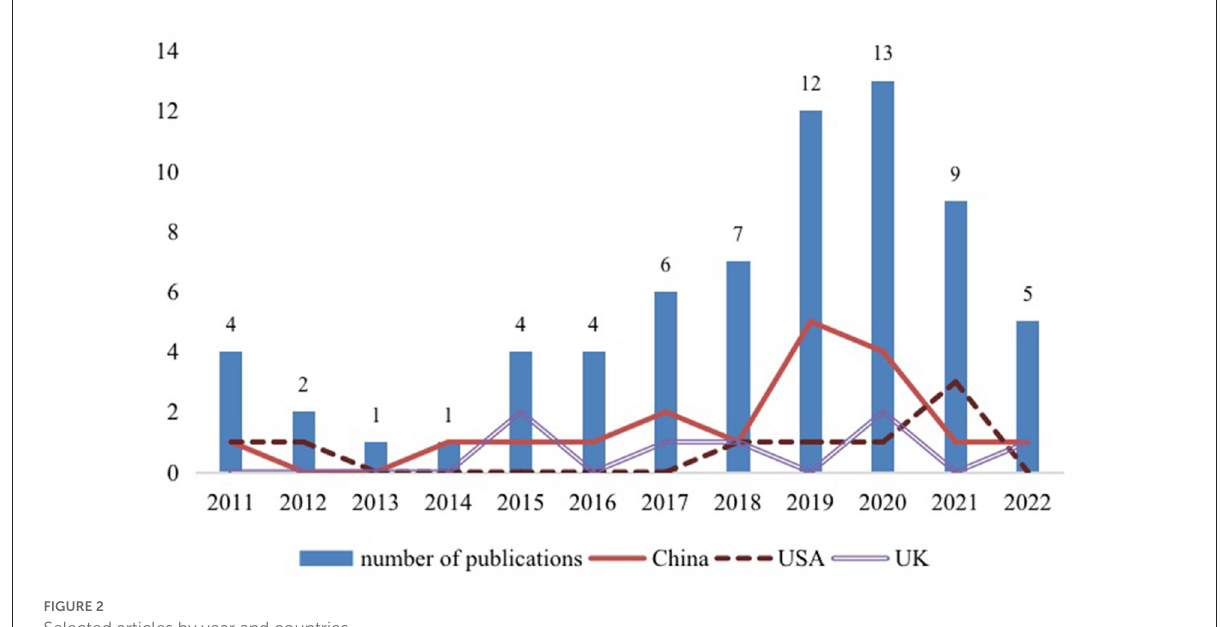
FIGURE2 Selected articles by year and